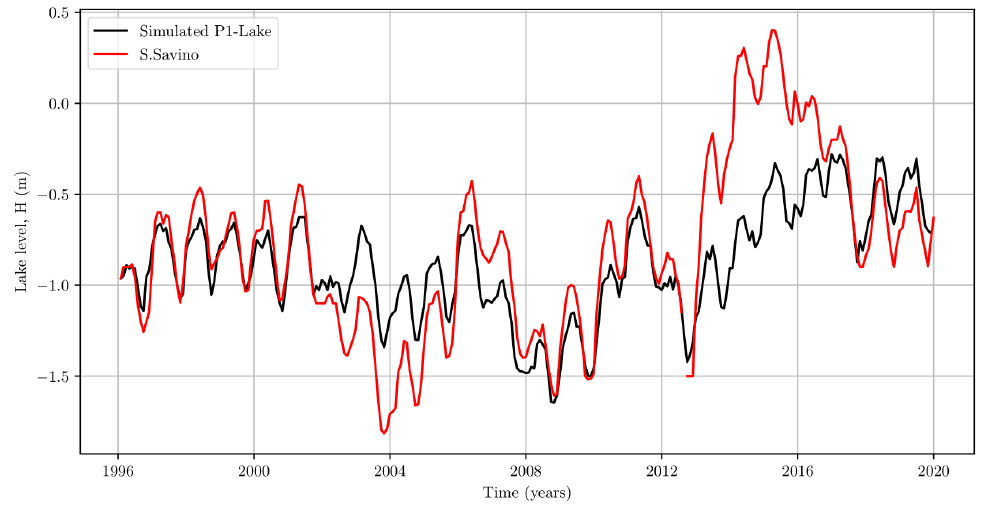
Figure 8. Monthly lake level, H , simulated (in black) by Equation (7) vs. observed (in red) values at S. Savino. In the model, the validation period is from 1996 to 2000, whereas the simulation one is from 2000 to